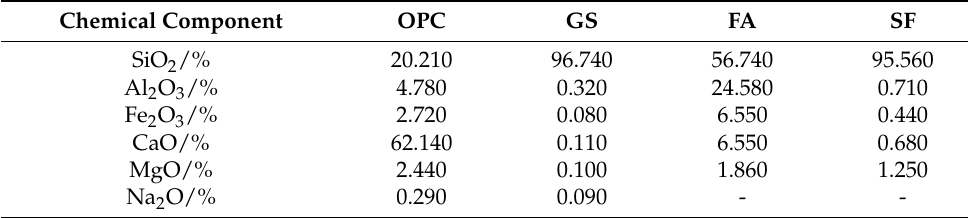
Table 3. Chemical components of OPC, GS, FA and SF by wt.%.